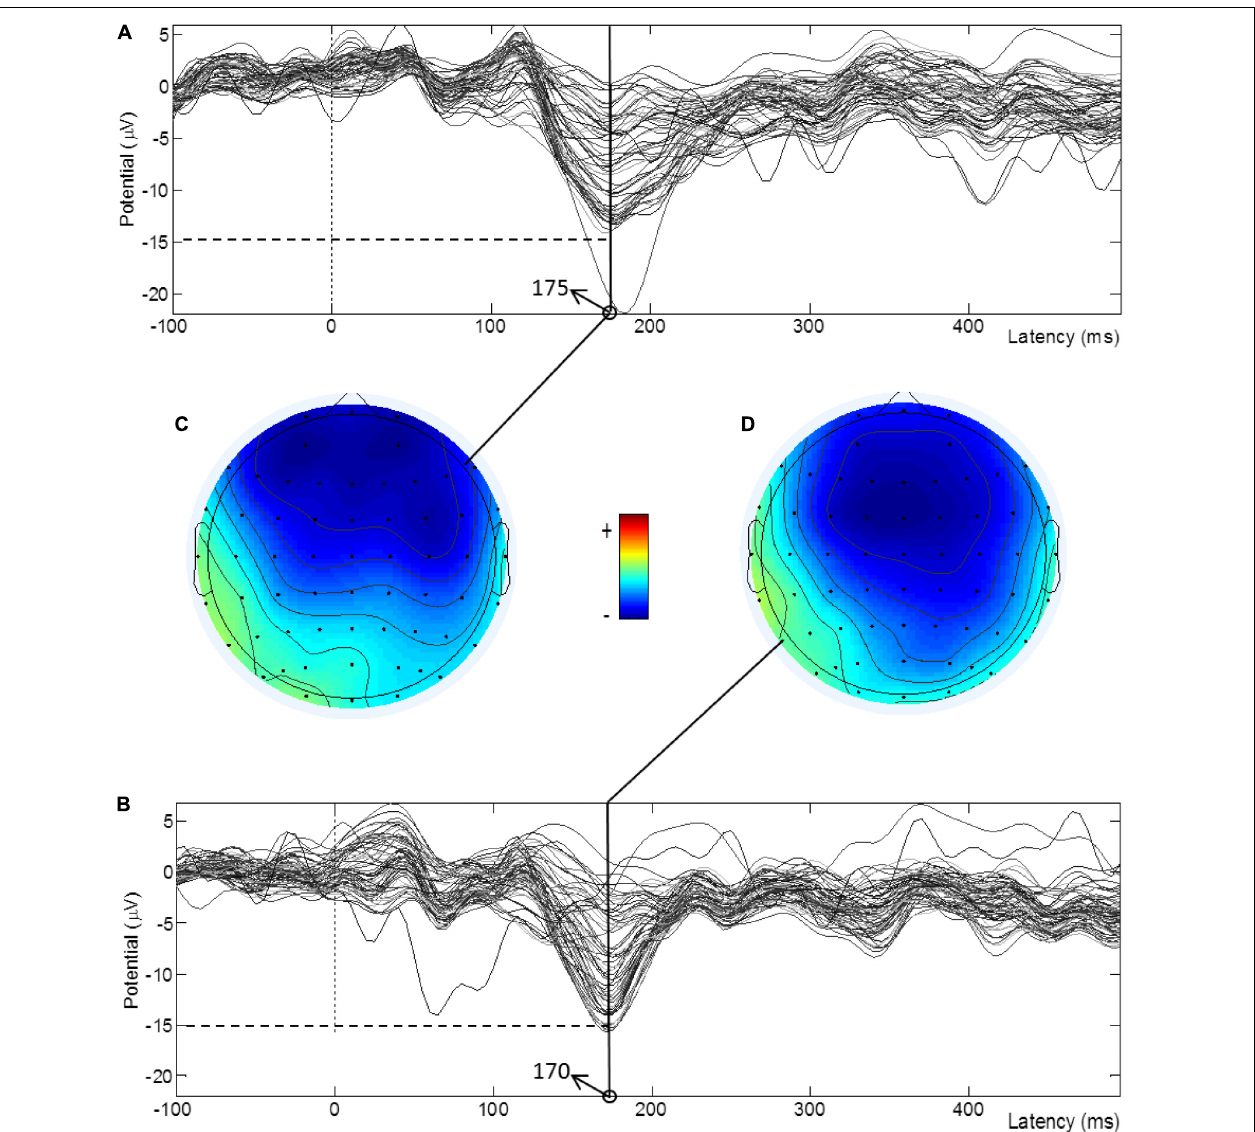
FIGURE 3 | TDS-evoked MMN waveforms of all electrodes pre- and post-treatment for a subject in the atDCS group and the amplitude brain topographies at the peak moments. (A) MMN waveform before treatment. (B) MMN waveform after treatment. (C) Peak amplitude topographic map before treatment. (D) Peak amplitude topographic map after